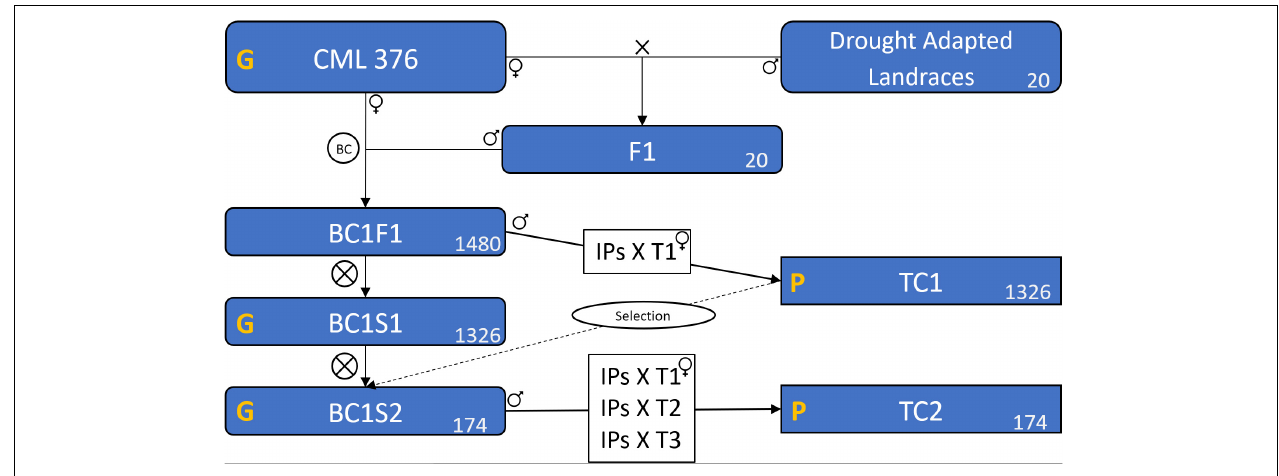
FIGURE 1 | Scheme of the plant material formation showing the populations, the crosses, and the testcrosses. CML 376 is the maize line used as recurrent parental. The X means a cross. BC represents the backcross between the F1s and the CML 376. BC1F1 is the population resulted from the backcross, BC1S1 is the result of BC1F1 self-pollination, likewise, BC1S2 is the population resulted from BC1S1 self-pollination. The ⊗ means a self-pollination. TC1 and TC2 are the two testcross trials carried as field experiments. IPs is Individual Plants of the BC1F1 and BC1S2 that were crossed with the tester(s). T1, T2, and T3 are the three tester genotypes. The yellow G means that the population was genotyped, and P means that the field trials were phenotyped. The number in the lower left corner of the boxes is the number of genotypes, or populations in the case of Landraces and F1. The “Selection” on a dashed line means that we used the results of TC1 to select the superior BC1S1 genotypes, this process selected the 174 superior genotypes among the 1326 existing in BC1S1, the selected genotypes formed the